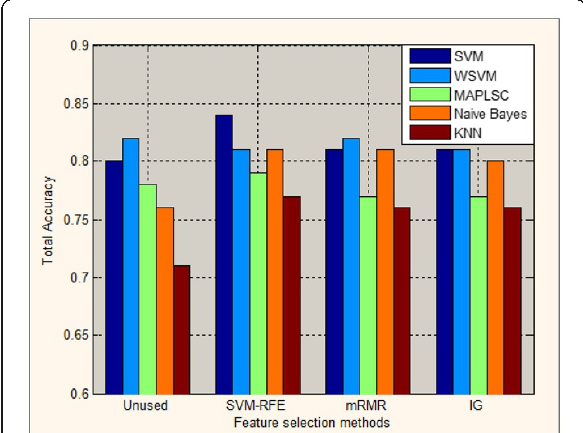
Figure 9 Perfection accuracy of lip image classification on